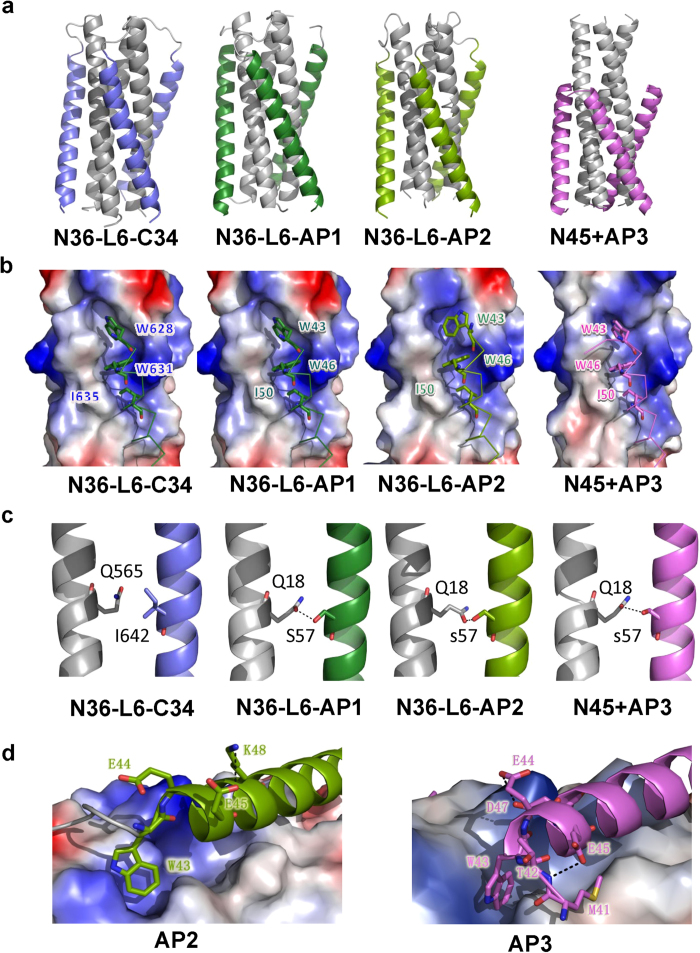
Crystal structure of N36-L6-C34, N36-L6-AP1, N36-L6-AP2, and N45 + AP3 complexes.Colored identically, NHR is in grey, C34 in slate, AP1 in forest, AP2 in split pea and AP3 in violet. (a) Cartoon representation of 6-HB structure. (b) AP1, AP2 and AP3 are buried inside the hydrophobic pocket formed by NHR. (c) AP1, AP2 and AP3 bind to NHR more closely than CHR-peptide C34. The interaction residues are shown in stick representation and are properly labeled. Hydrogen bonds are shown in dark grey dashed lines. (d) Different structural characteristics of AP2 and AP3.Colored identically, AP2 is in split pea, and AP3 is in violet. The interaction residues are shown in stick representation and are properly labeled in separate colors.